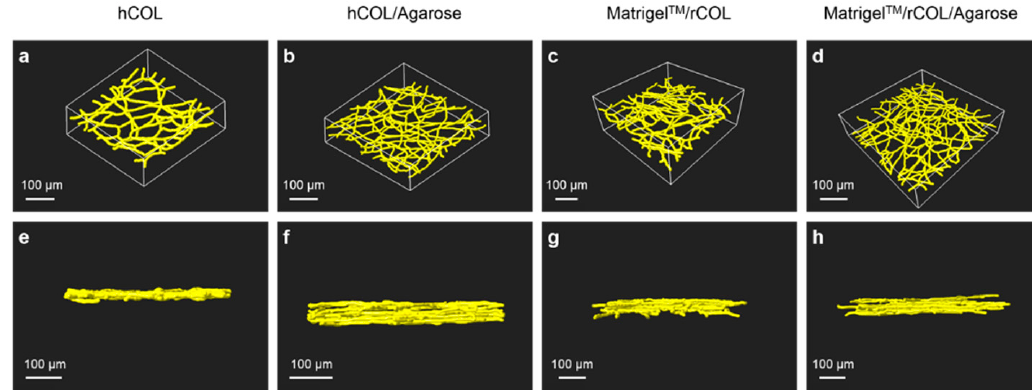
Figure 4. A 3D reconstruction of EC networks revealing the effect of agarose supplementation on the network structure and thickness. 3D reconstruction of multiphoton images obtained from constructs containing GFP ‐ HUVECs and hASCs in hCOL ( a , e ), hCOL/Agarose ( b , f ), Matrigel TM /rCOL ( c , g ) or Matrigel TM /rCOL/Agarose ( d , h ) cultivated for 14 days. ( a – d ) 3D reconstruction of EC network employing the calculated mean diameter for each hydrogel setting. ( e – h ) Side view of the 3D reconstruction demonstrating the height of the EC network. Networks generated in agarose supplemented hCOL hydrogel are multi ‐ layered with larger height and exhibit a smaller mean diameter compared to constructs generated with hCOL which have a mono ‐ layer structure with thinner height. Networks generated in constructs generated with Matrigel TM /rCOL/Agarose are multi ‐ layered with same height and exhibit a slightly smaller mean diameter compared to networks